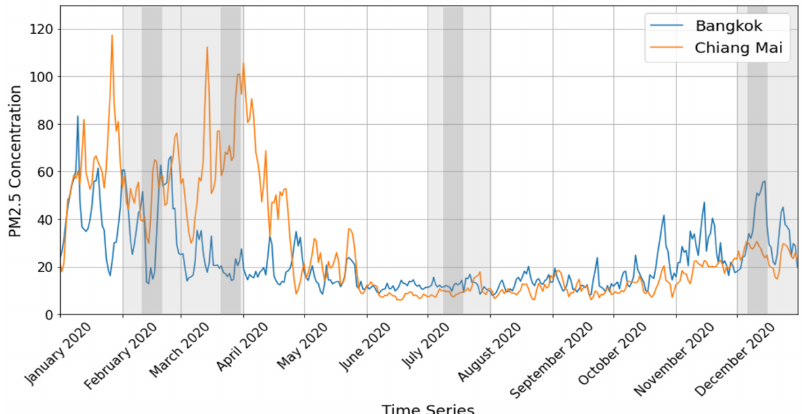
Figure 3. Daily averaged PM 2 . 5 concentrations over Bangkok (blue curve) and Chiang Mai (orange curve) for the year 2020. The light and dark grayed areas correspond to the monthly and 10-day time windows respectively selected in this study as representative of the four unique scenarios for the PM 2 . 5 temporal distribution.